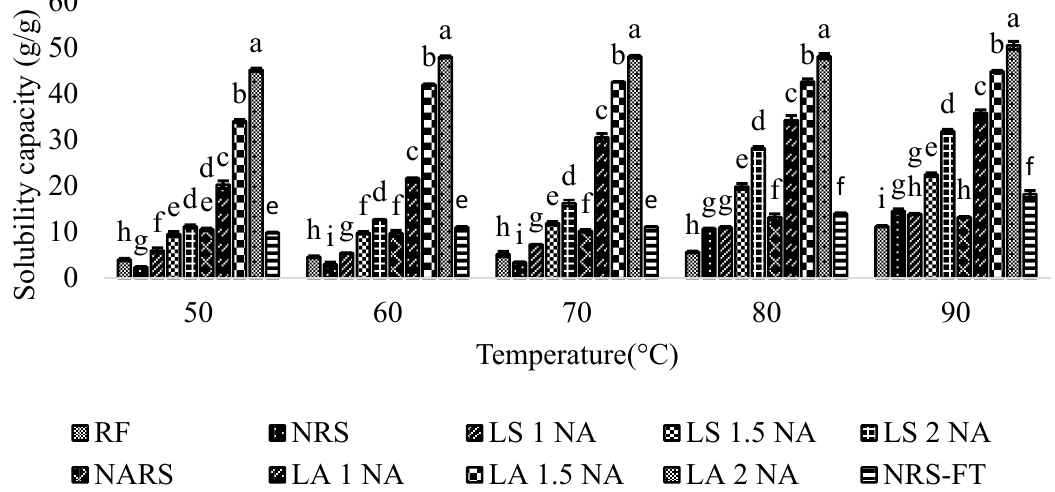
Figure 1. Solubility capacity of the RD 31 flour, native starch, and modified starches at different temperatures. Di ff erent su ffi x (a–f) within the same temperature indicate significant di ff